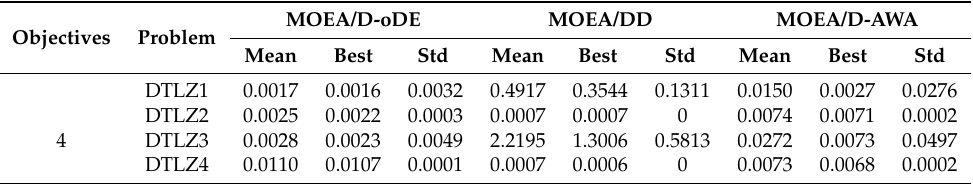
Table 7. Statistics of the GD metric obtained by MOEA/D-oDE, MOEA/DD and MOEA/D-AWA on DTLZ1–DTLZ4 with 4 objectives.